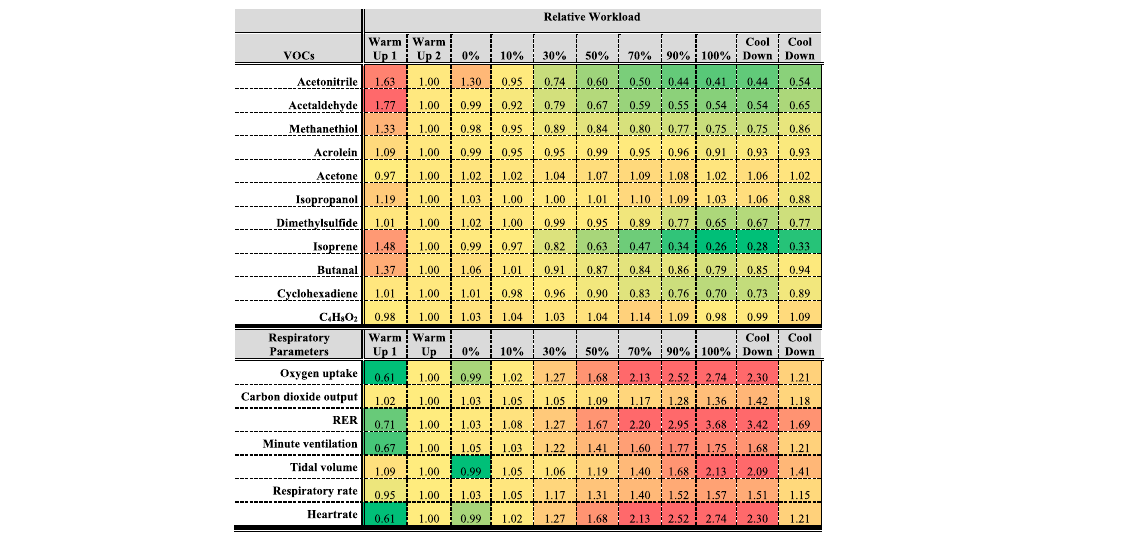
TABLE 2 Heatmap based on normalized mean data from all 14